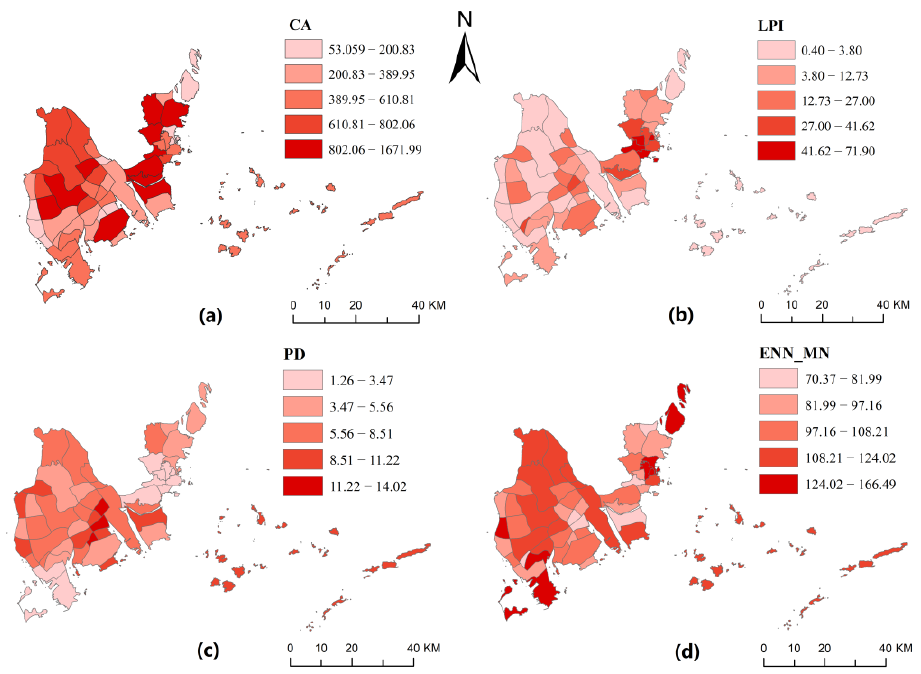
Figure 3. Spatial distribution of landscape spatial form index in Zhuhai: ( a ) CA, ( b ) LPI, ( c ) PD, and ( d )